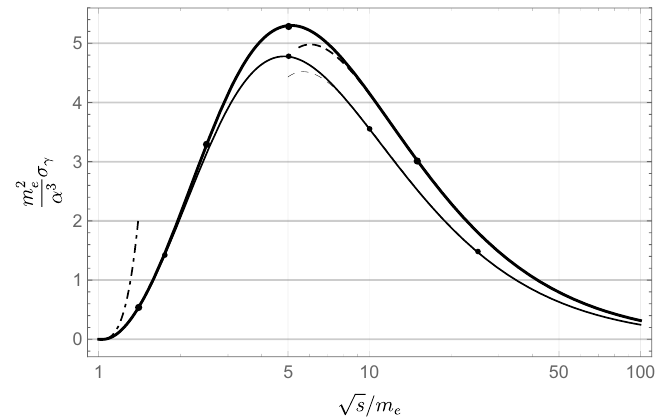
√ Figure 5. Exact cross section as a function of s/m e at ω 0 = 0 . 01 m e . The upper thick line — the cross section in electron rest frame, the lower thin line — in center-of-mass frame, dashed lines — the high-energy asymptotics (3.19), (3.20), dash-dotted line — the threshold asymptotics (3.18), points — Cuba numerical integration of the differential cross